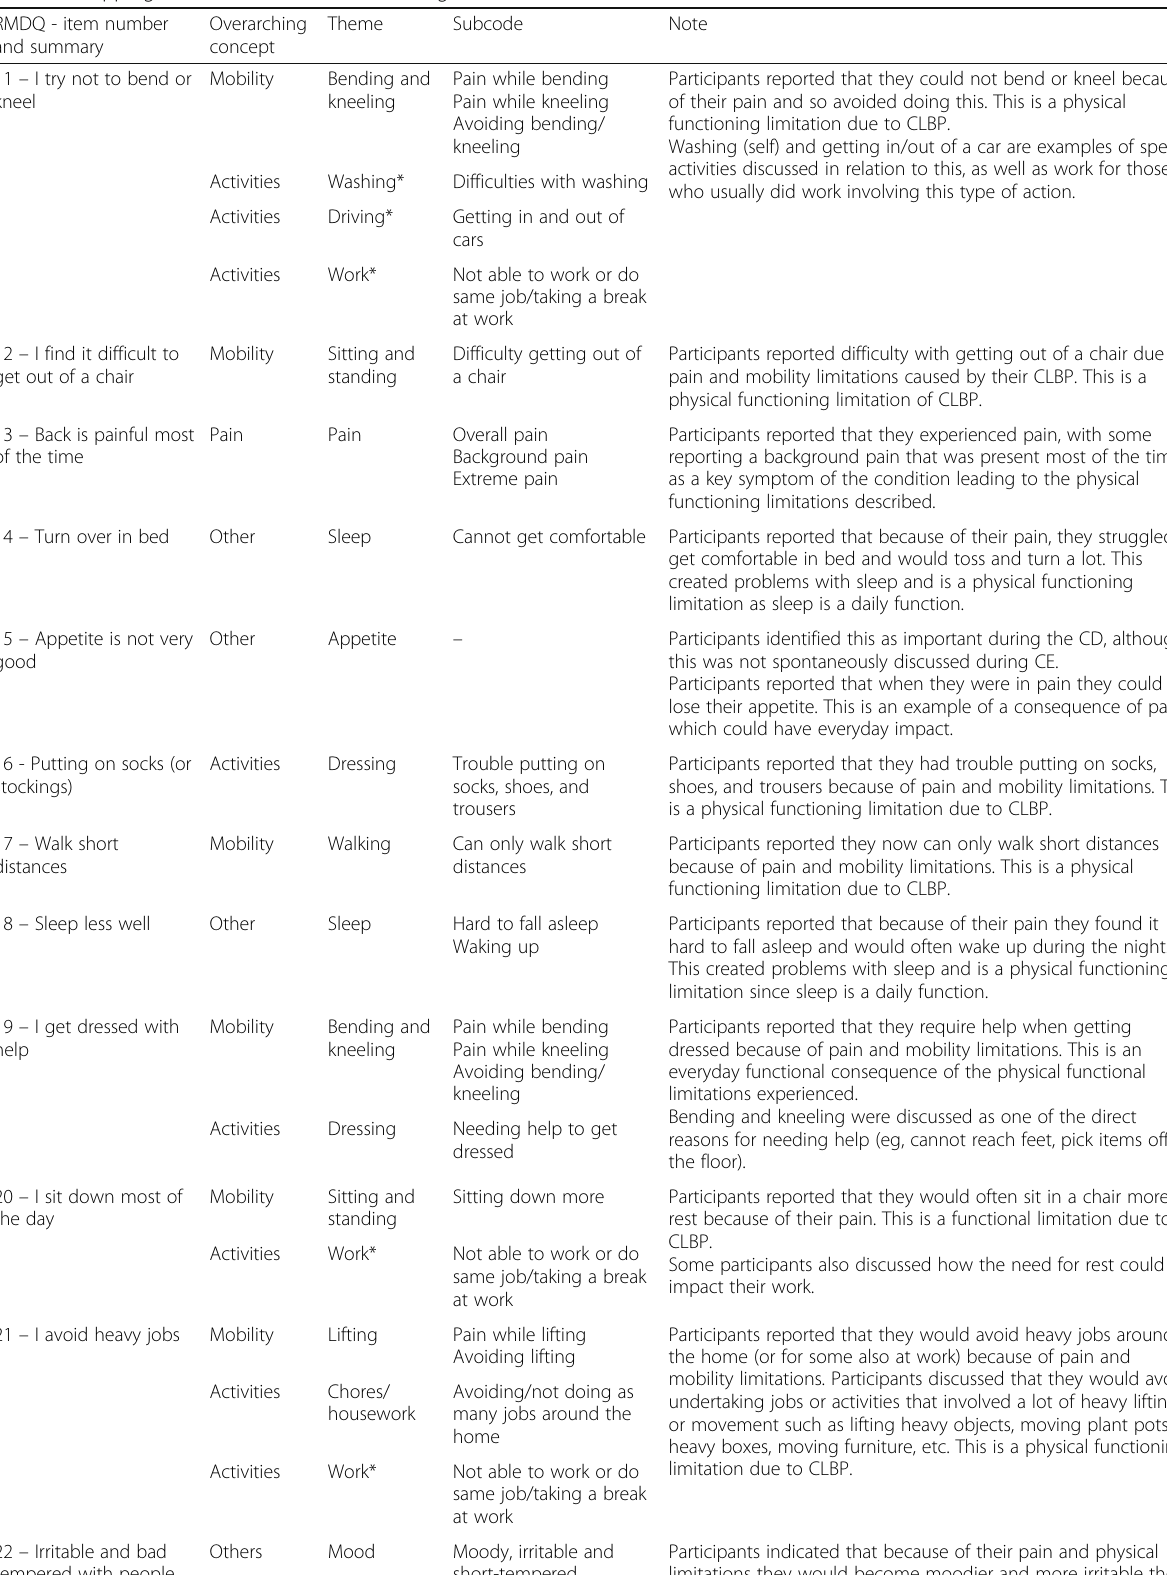
Table 3 Mapping the themes identified in coding to the RMDQ items (Continued) RMDQ - item number and